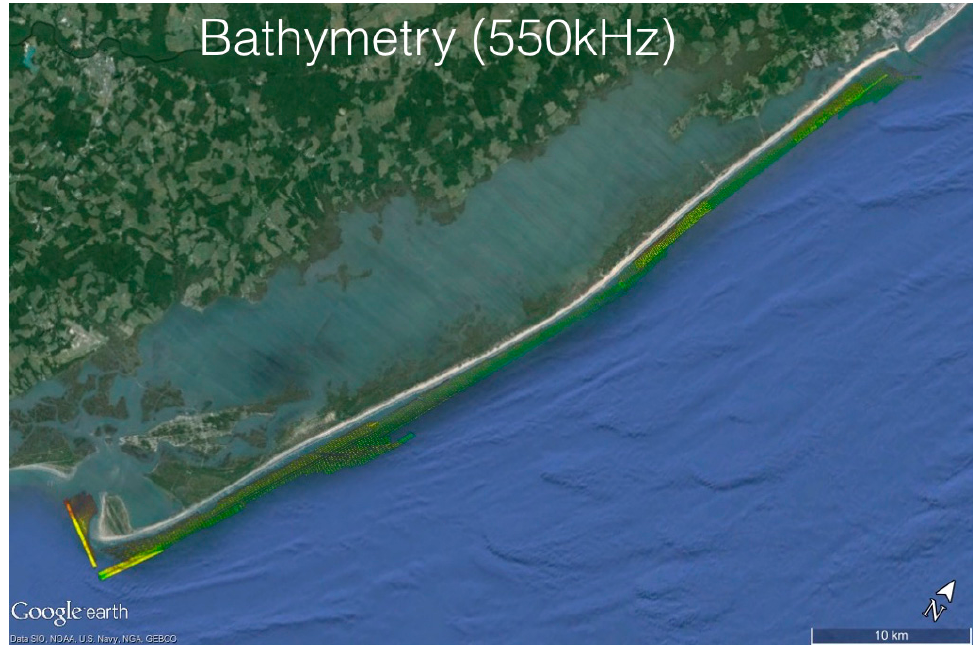
Figure 7. Bathymetry mosaic (1m / pixel) from 2014–2015 acoustic surveys (550 kHz) for the entire study area. Notable features captured in the bathymetry included pronounced shore-attached oblique bars.